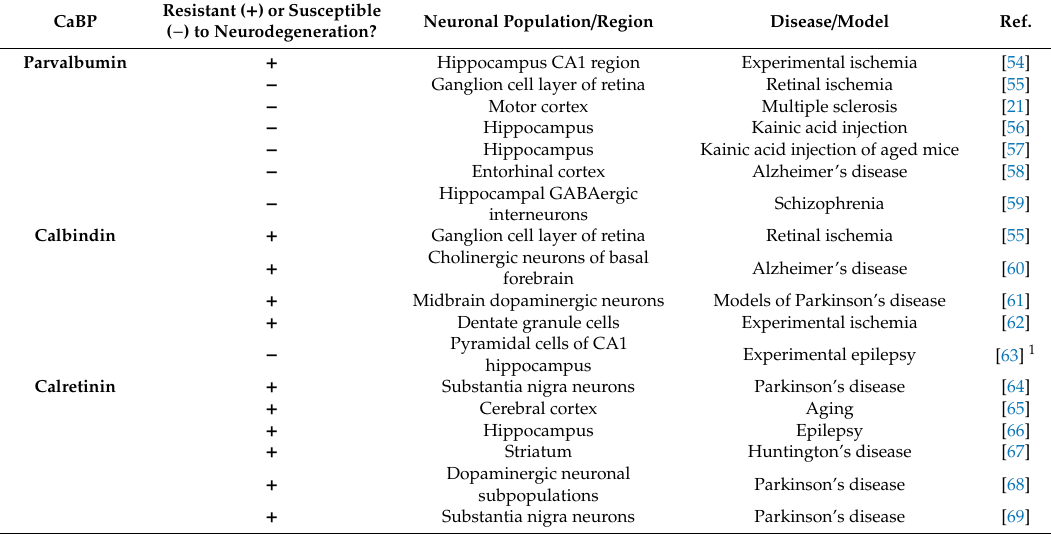
Table 2. In vivo correlation of CaBP expression and susceptibilities of neuronal populations to disease and disease